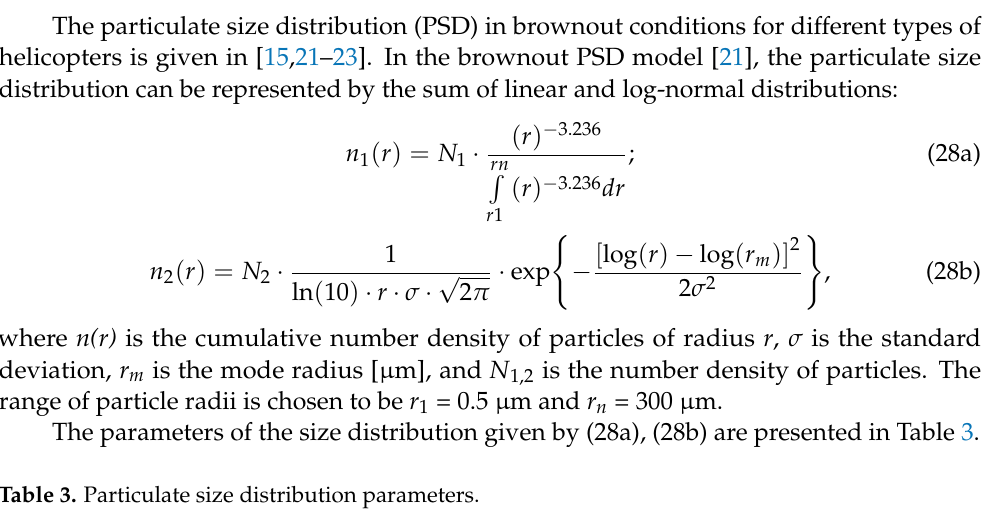
Table 3. Particulate size distribution parameters.